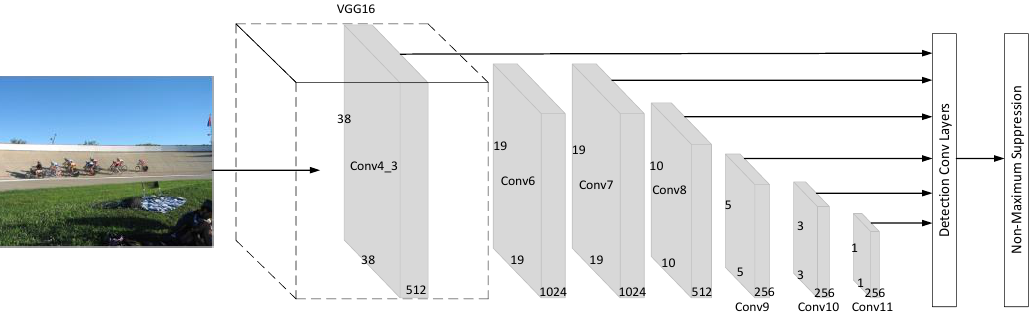
Figure 1. Network of Single-Shot MultiBox Detector (SSD).